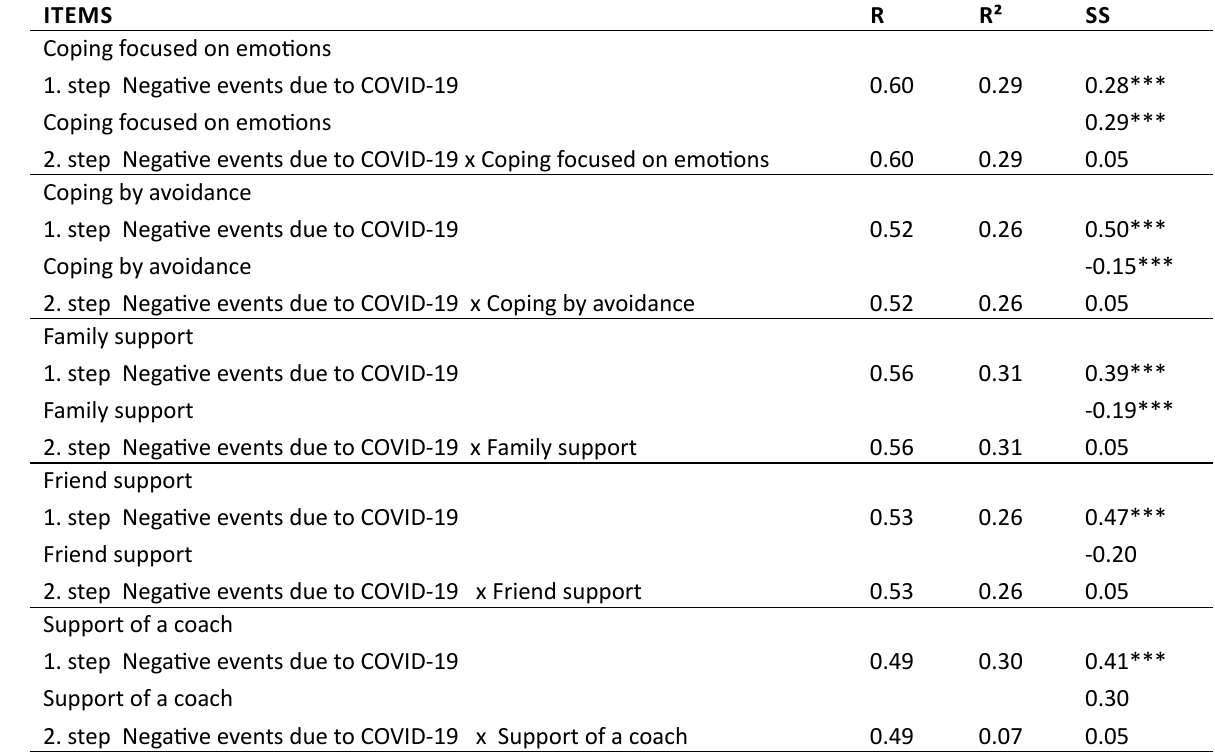
Table 3b. Hierarchical regression analysis for depression criterion